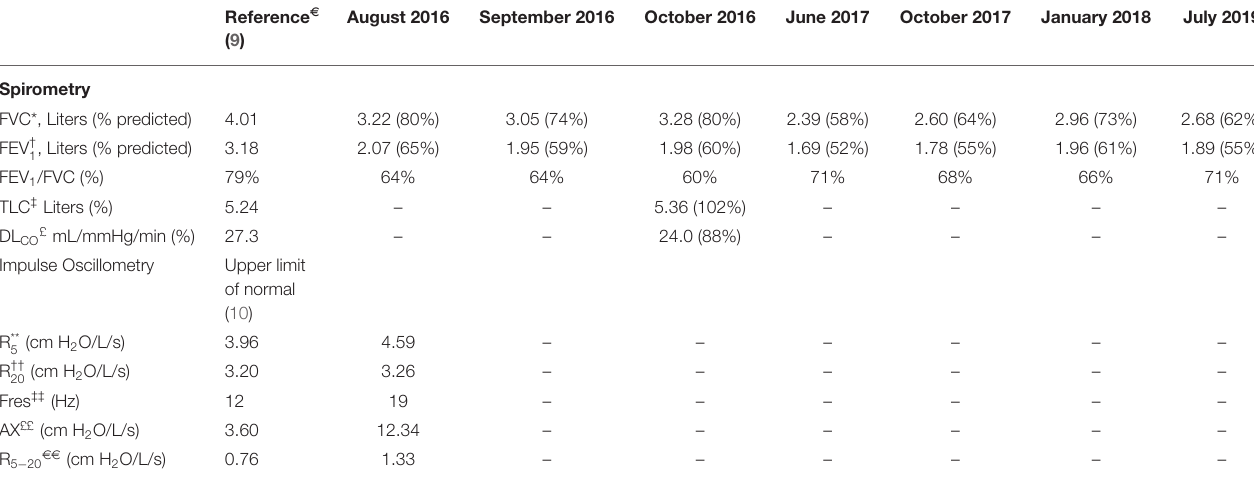
TABLE 1 | Lung function testing results of worker diagnosed with flavoring-related lung disease, September 2016–July